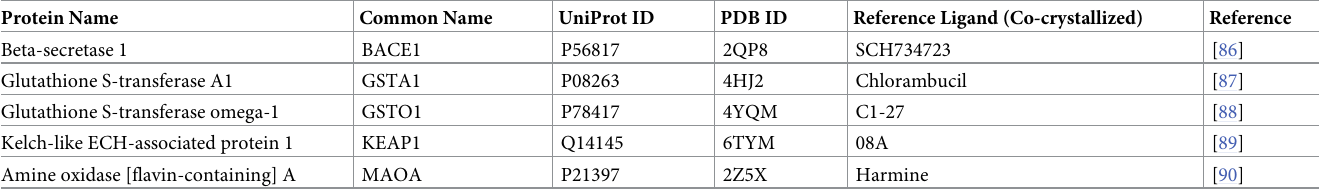
Table 1. Information of protein